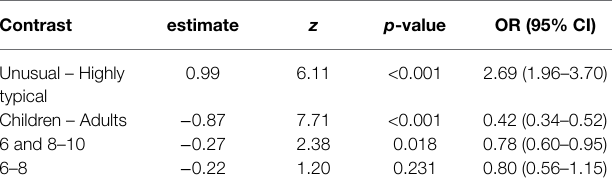
TABLE 8 | Contrasts following the generalized mixed model on accuracy in Experiment 2 for Type of item and Age group.